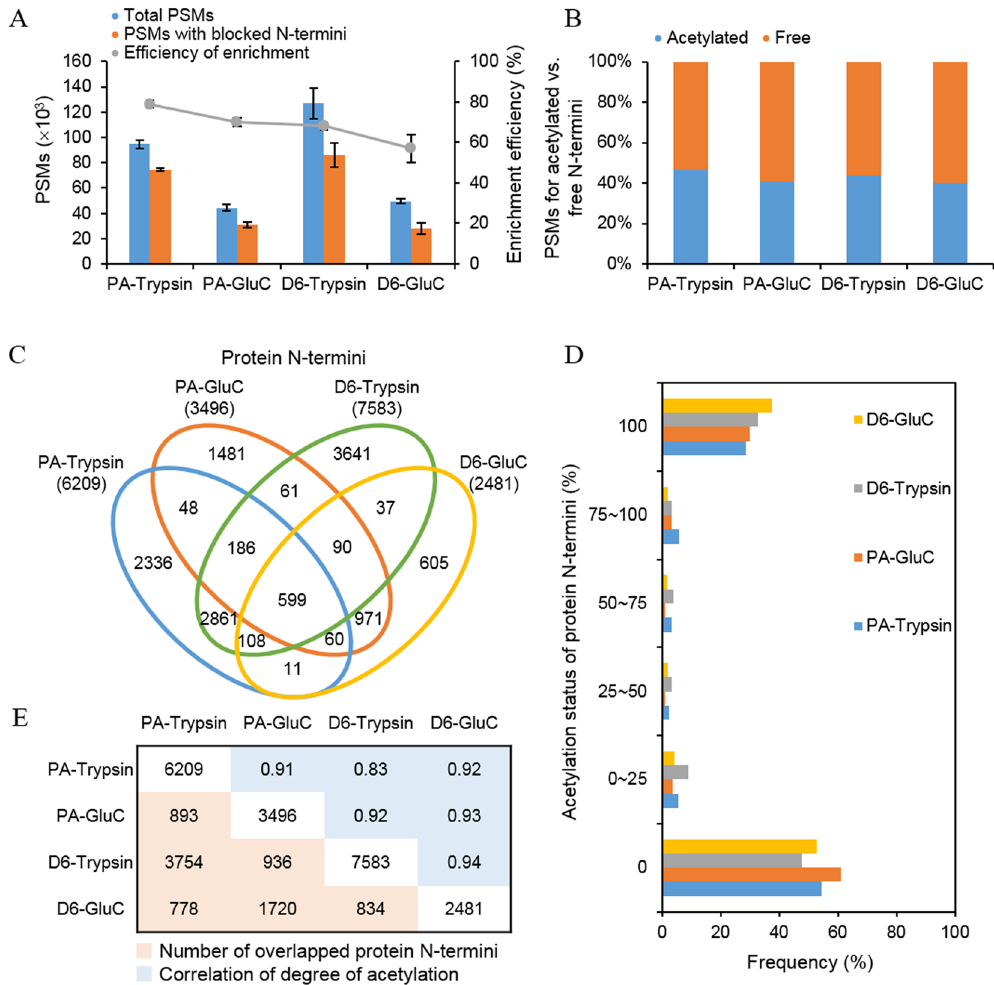
Figure 2. Properties of discovered N-terminome. ( A ) Number of PSMs identified on each set of Nrich experiment. In all cases, the trypsin-treated N-terminome have more PSMs than GluC-treated N-terminome. In the case of the N-blocking reagents, propionic anhydride (PA) showed higher efficiency by more than 10% compared to D6-acetic anhydride (D6). However, in the aspect of PSM counts, D6 treated samples had higher values than those of PA-treated samples. ( B ) Proportions of PSMs for endogenously acetylated N-termini (blue) and endogenously free N-termini (orange). About 44% of PSMs corresponded to acetylated N-termini. ( C ) Venn diagram of discovered protein N-termini according to different experimental setup. ( D ) Acetylation status of the discovered protein N-termini. The degree of acetylation was calculated based on the number of PSMs. ( E ) Protein N-termini discovered commonly between each pair of experimental setups and the correlation of degree of